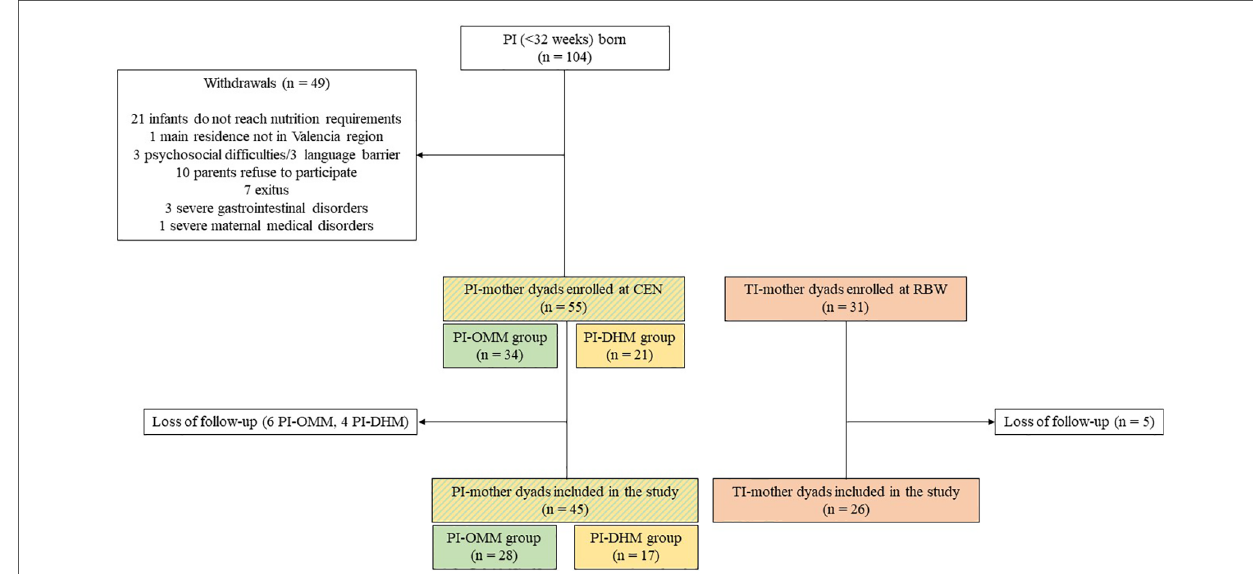
FIGURE 4 Prospective fl ow chart of the NUTRISHIELD study. PI, preterm infant; TI, term infant; CEN, complete enteral nutrition (150 ml/kg/day); RBW, recovery of birth weight; OMM, own mother ’ s milk; DHM, donor human